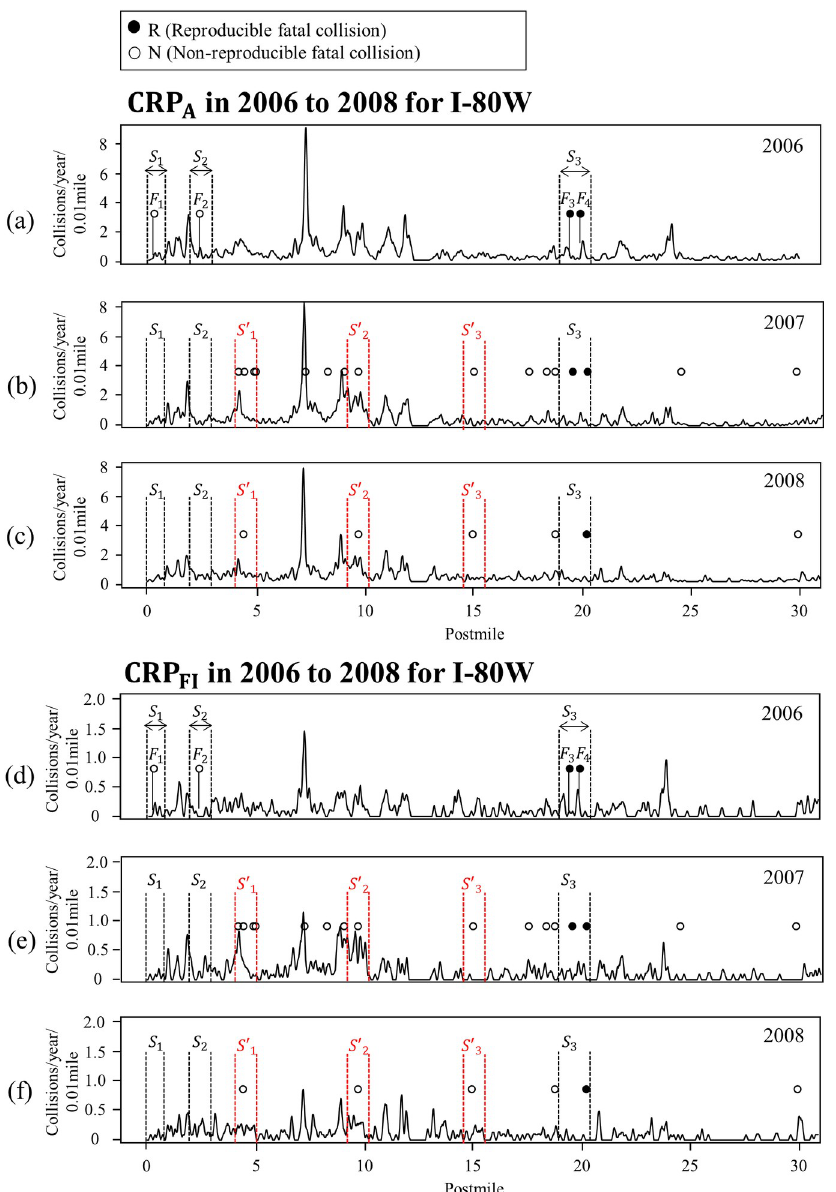
Fig 2. Fatal collision locations with CRP A in (a) 2006, (b) 2007, and (c) 2008, and fatal collision locations with CRP FI in (d) 2006, (e) 2007, and (f)